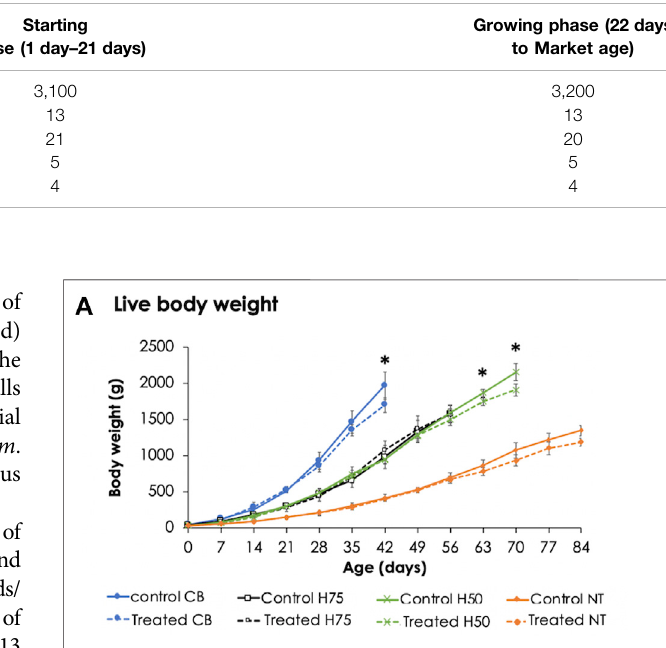
TABLE 1 | Chemical composition of standard commercial broiler diets.